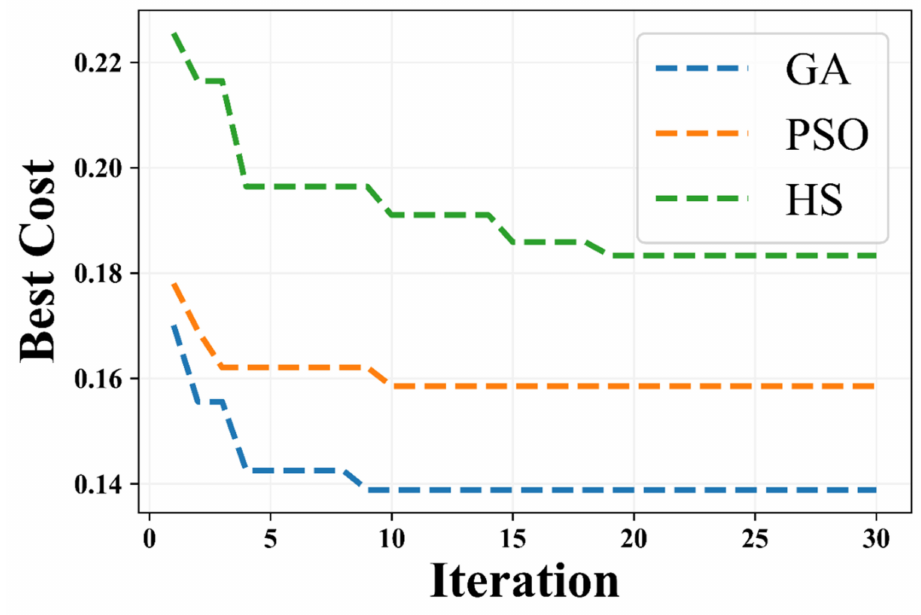
Figure 7. DTB algorithm optimization convergence